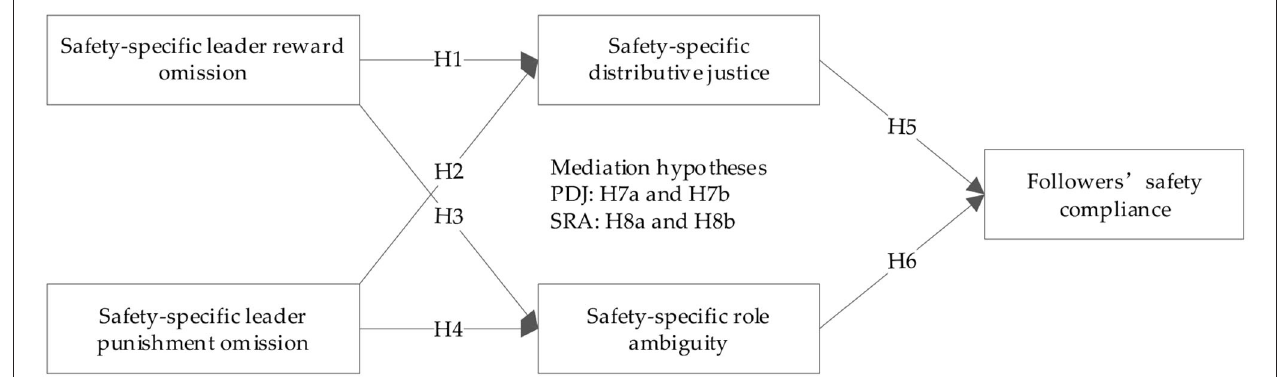
FIGURE 1 | Hypothesized research